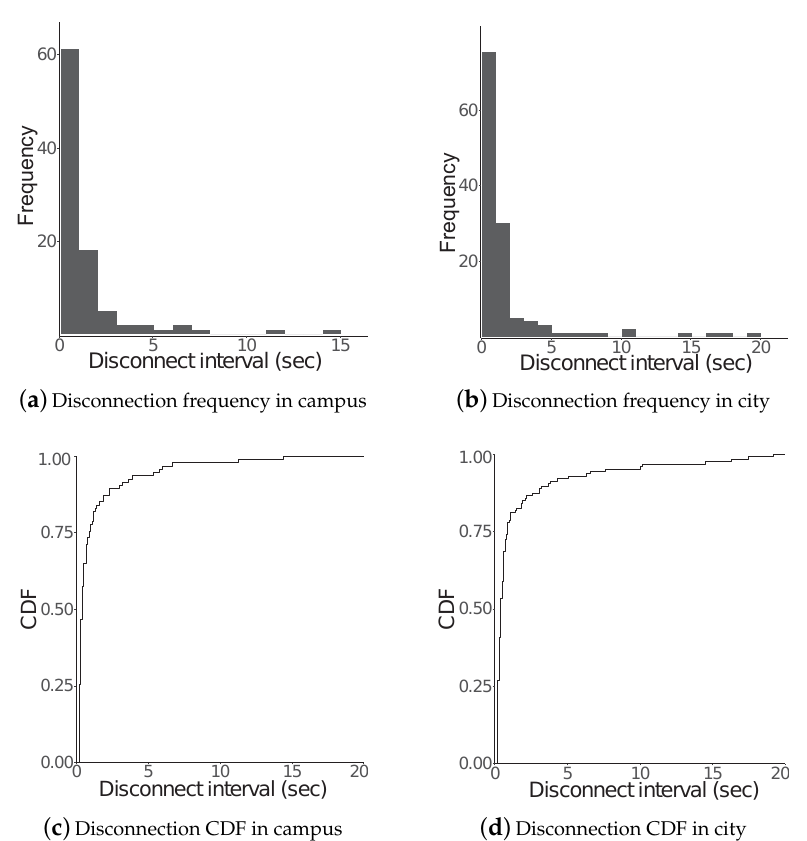
Figure 11. Campus and city road